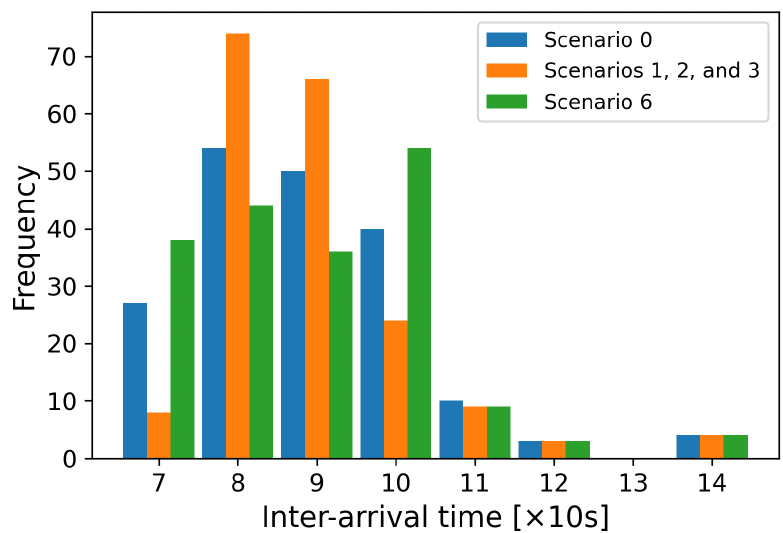
Figure 14. Histogram of inter-arrival times for each